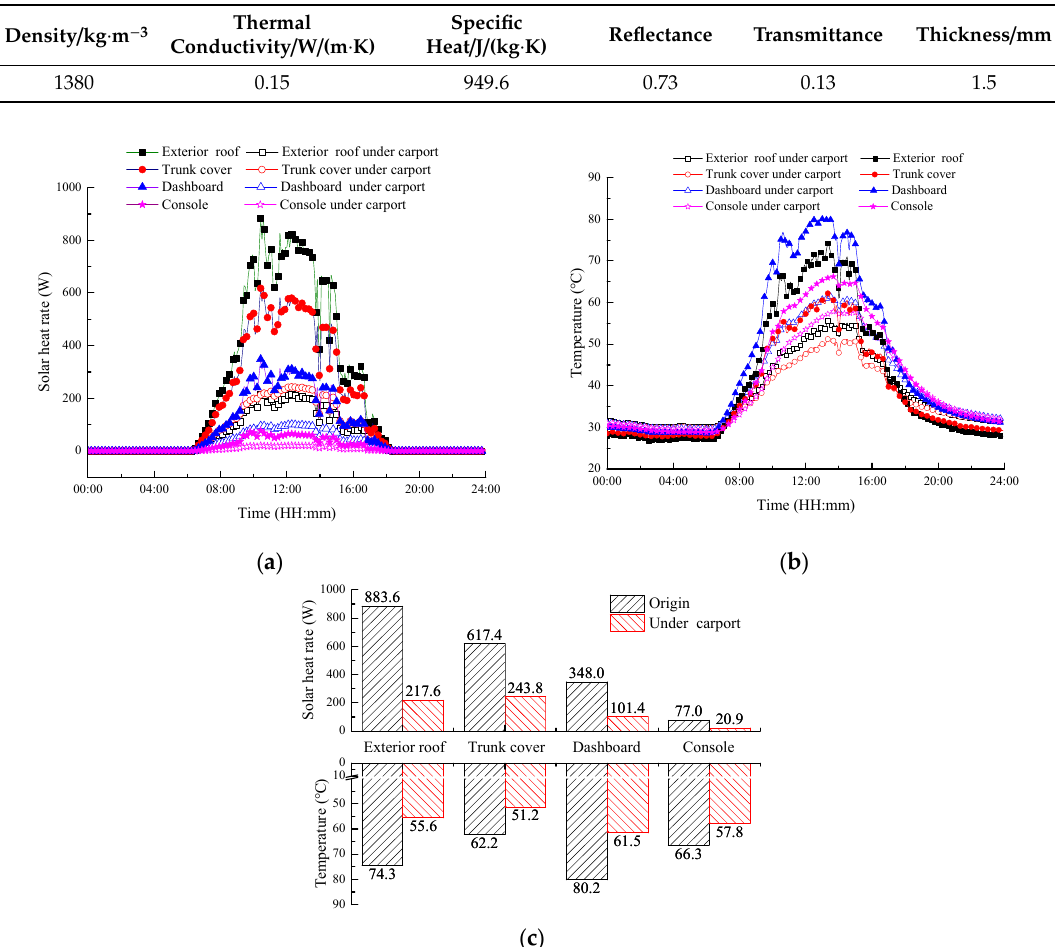
Table 8. Setting Physical property parameters of membrane structure roof.